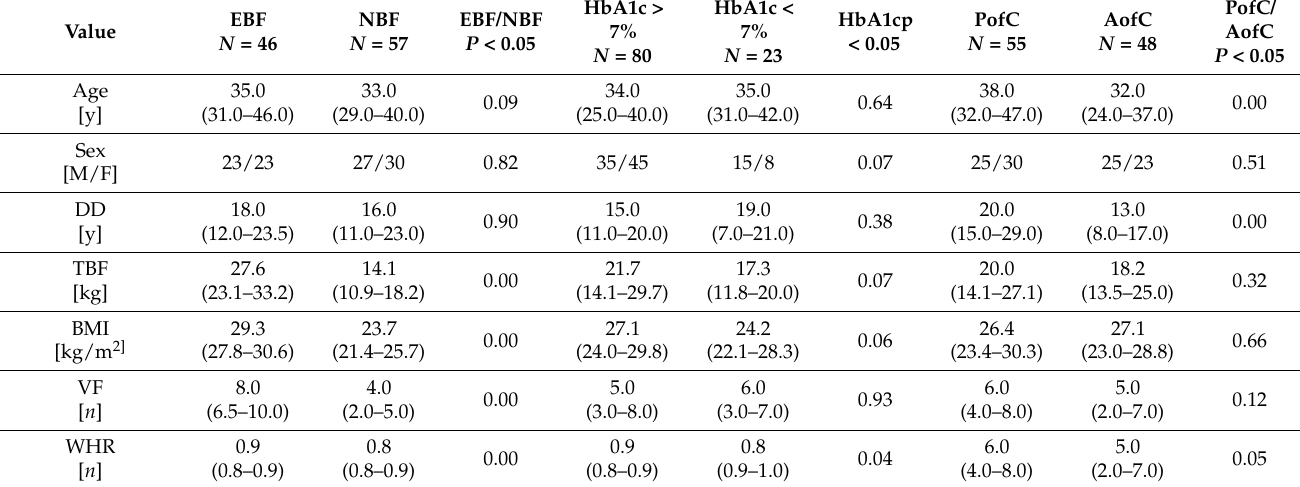
Table 3. Clinical characteristics of the study groups (excess body fat vs. normal body fat), (diabetes control, HbA1c < 7) and (presence of complication vs. absence of complication). Data are presented as medians with interquartile